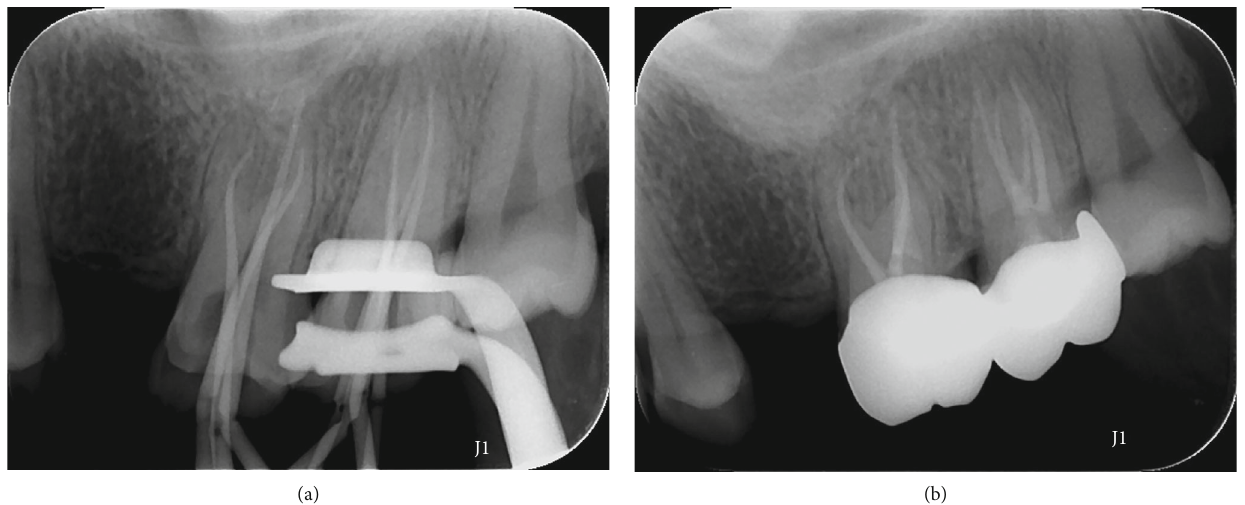
Figure 4: (a) Radiograph to con fi rm the working length, (b) postoperative